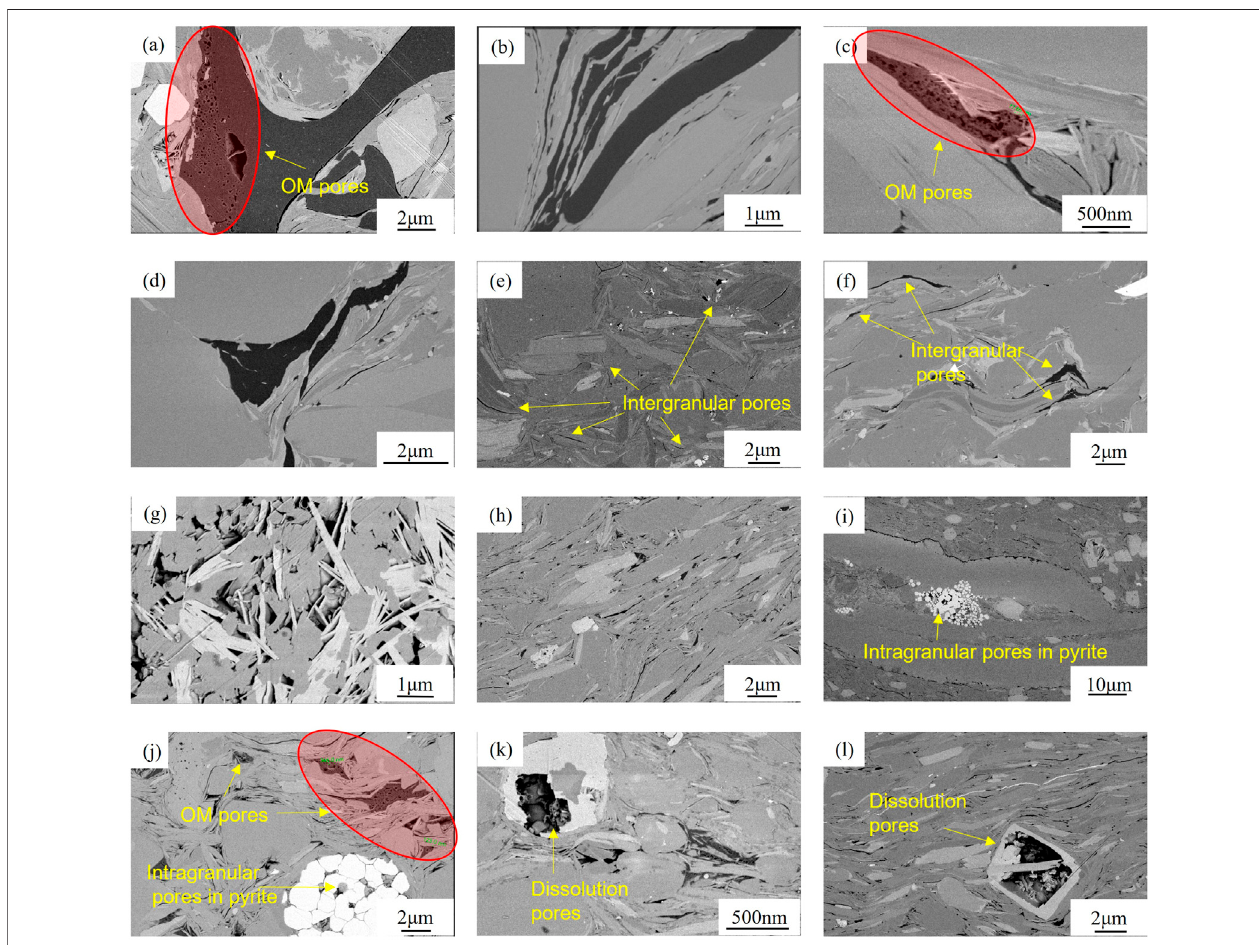
FIGURE 2 | Pores of the continental shale reservoir in northeastern Sichuan Basin. (A) Da ’ anzhai Member from YL-4 Well, 3748.23 m, organic matter pores; (B) Da ’ anzhai Member from YL-4 Well,3760.75 m, dense structure oforganic matterwithoutorganic matterpores; (C) Dongyuemiao Member fromFY-1 Well, 2736.30 m, organic matter pores; (D) DongyuemiaoMember from XL-101 Well, 2294.33 m, dense structure oforganic matter without organic matter pores; (E) Da ’ anzhai Member fromYL-4Well,4051.81 m,interparticlepores; (F) DongyuemiaoMemberfromXL-101Well,2294.33 m,asmallamountofbitumen fi lledinintergranularporesand poor development of pores; (G) Da ’ anzhai Member from YL-4 Well, 3790.14 m, micropores between clay minerals; (H) Dongyuemiao Member from XL-101 Well, 2275.55 m, micropores between clay minerals which are fi lled with bitumen; (I) Da ’ anzhai Member from YL-4 Well, 3748.23 m, intragranular pores in pyrite; (J) DongyuemiaoMemberfromFY-1Well,2708.41 m,intragranularporesinpyriteandorganicmatterporesinbitumen; (K) Da ’ anzhaiMemberfromYL-4Well,3790.14 m, dissolution pores in the ankerite; (L) Dongyuemiao Member from XL-101 Well, 2269.69 m, dissolution pores in the